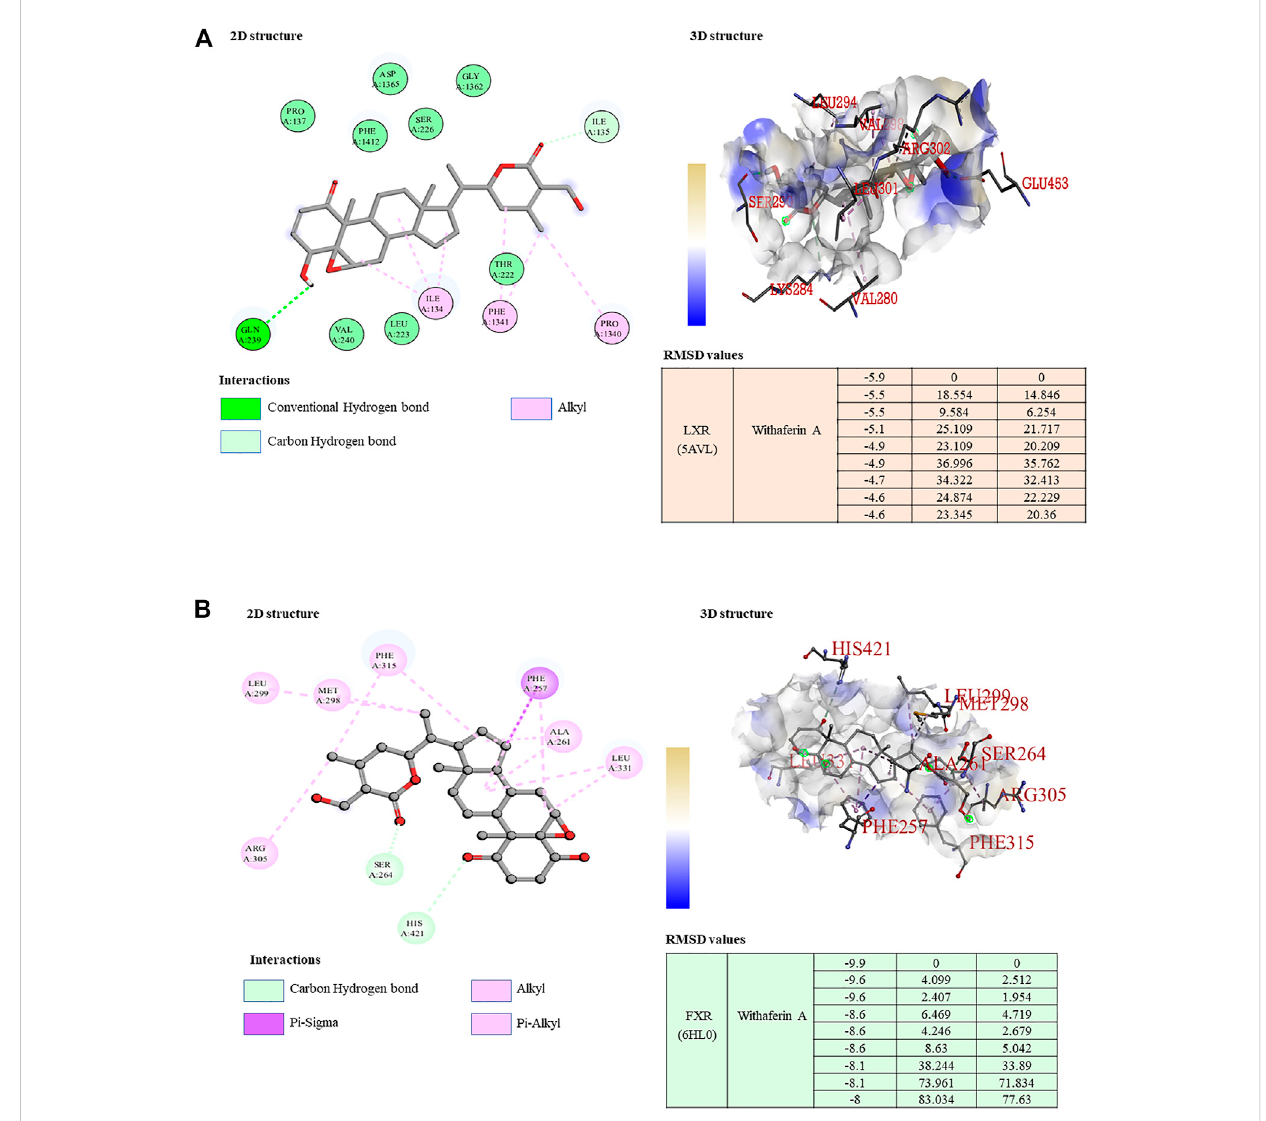
Withaferin A acts as a dual LXR/FXR receptor activator. (A,B) 2D and 3D visualization of the protein – ligand interaction of LXR (A) and FXR (B) with withaferin A; the table represents the binding af fi nity and RMSD values of the LXR/FXR receptor activator docked with withaferin